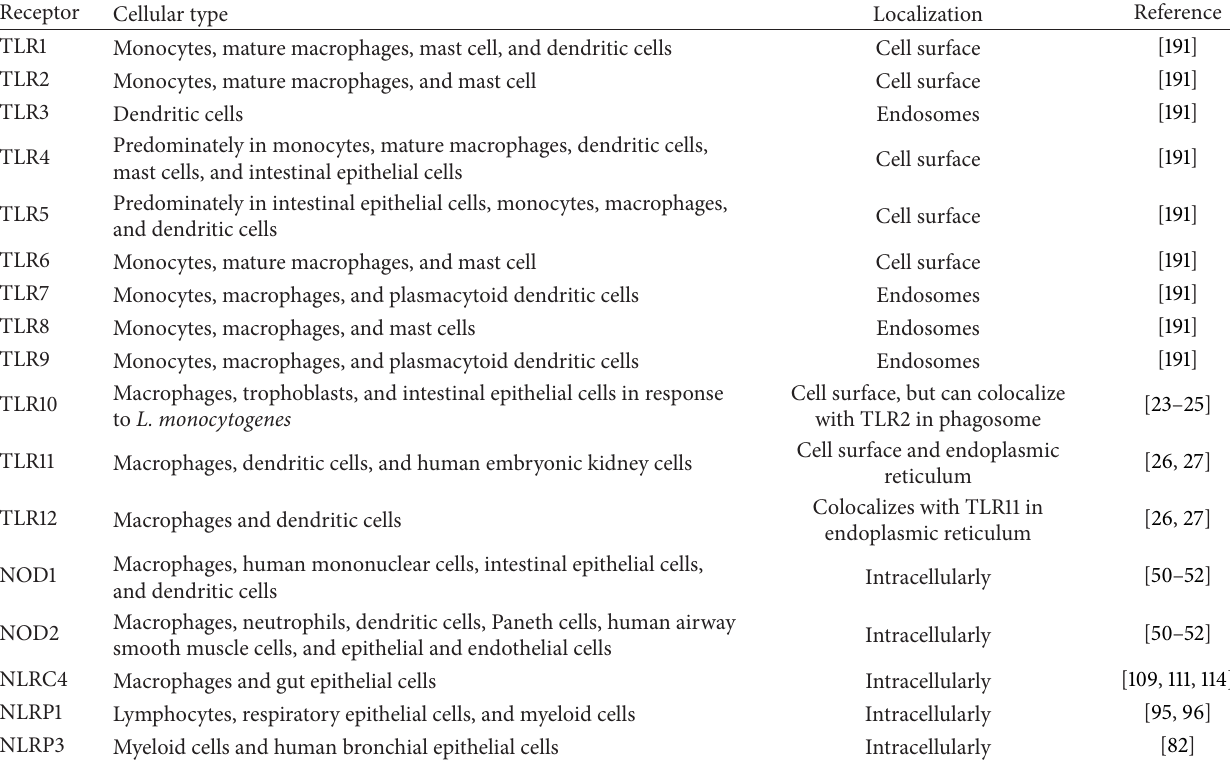
Table 1: Expression and localization of TLRs and NLRs in cellular